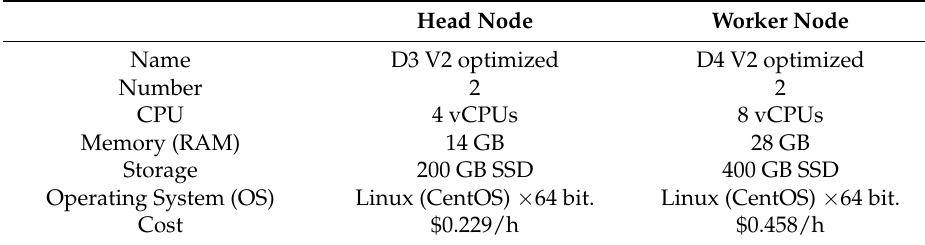
Table 5. Setup used to test our approach.